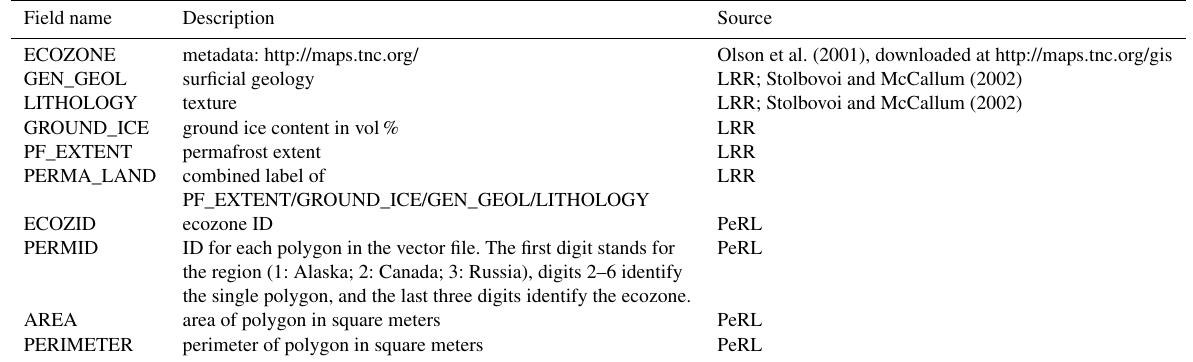
Table B3. Description of attributes contained in the polygon attribute table of Russian permafrost landscapes (russia_perma_land.shp).